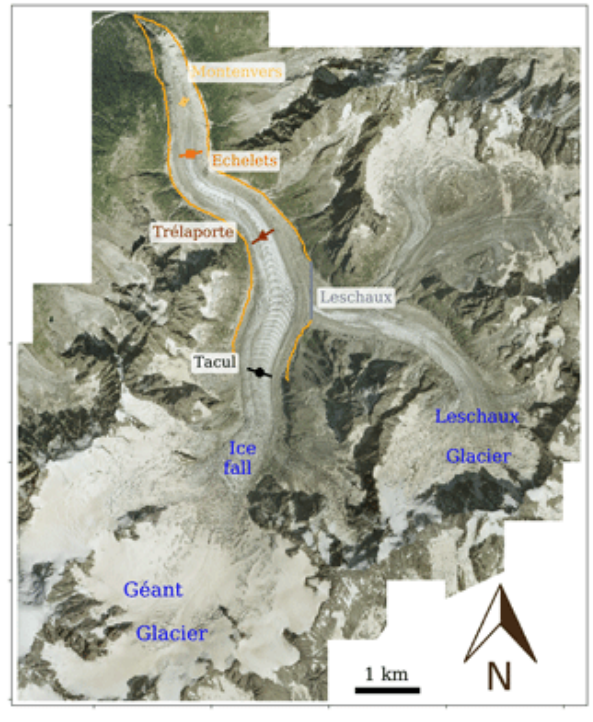
Figure 1. Map of Mer de Glace (orthophoto acquired in 2008 ©RGD74). The orange contour delimits the area modeled in this study. The location of the four cross sections (Tacul, Trélaporte, Echelets and Montenvers) and the Leschaux gate are indicated by the colored lines. The Tacul and Leschaux gates represent bound- ary gates where data are used to force the model, whereas the three other profiles represent internal gates where data are used to validate the